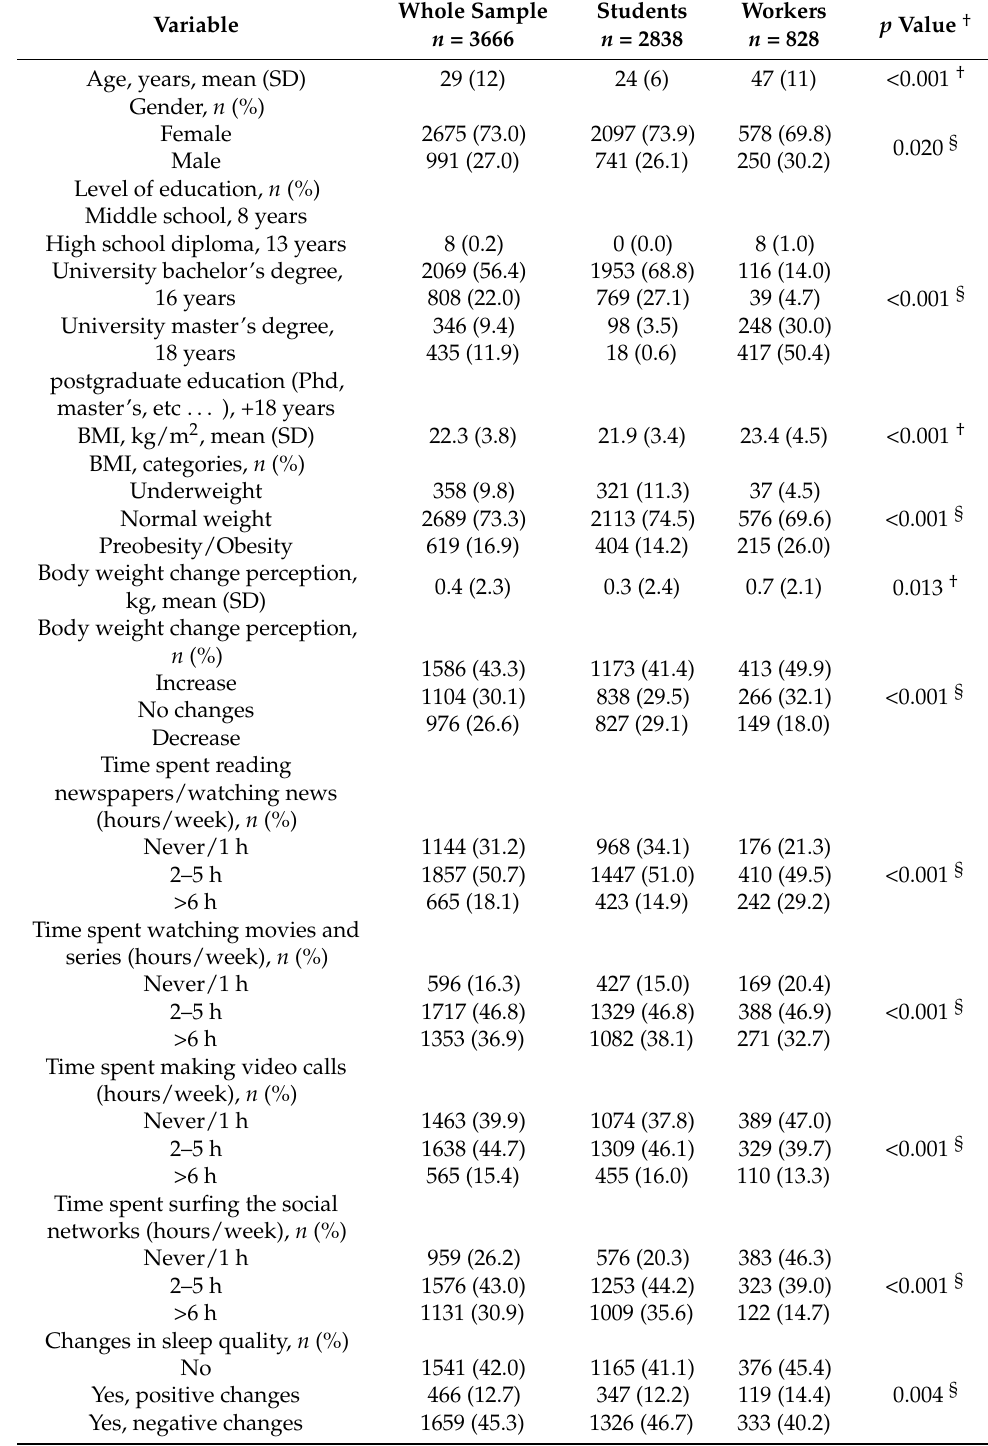
Table 1. Individual characteristics and sedentary daily activities during COVID-19 lockdown for the whole sample, students and